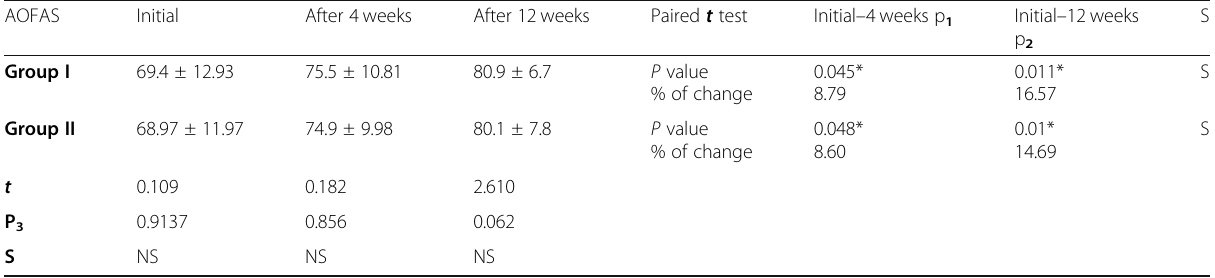
AOFAS American Orthopedic Foot and Ankle Society. p1, p2 change through time. Paired t test P 3: difference between groups I and II at each time * P